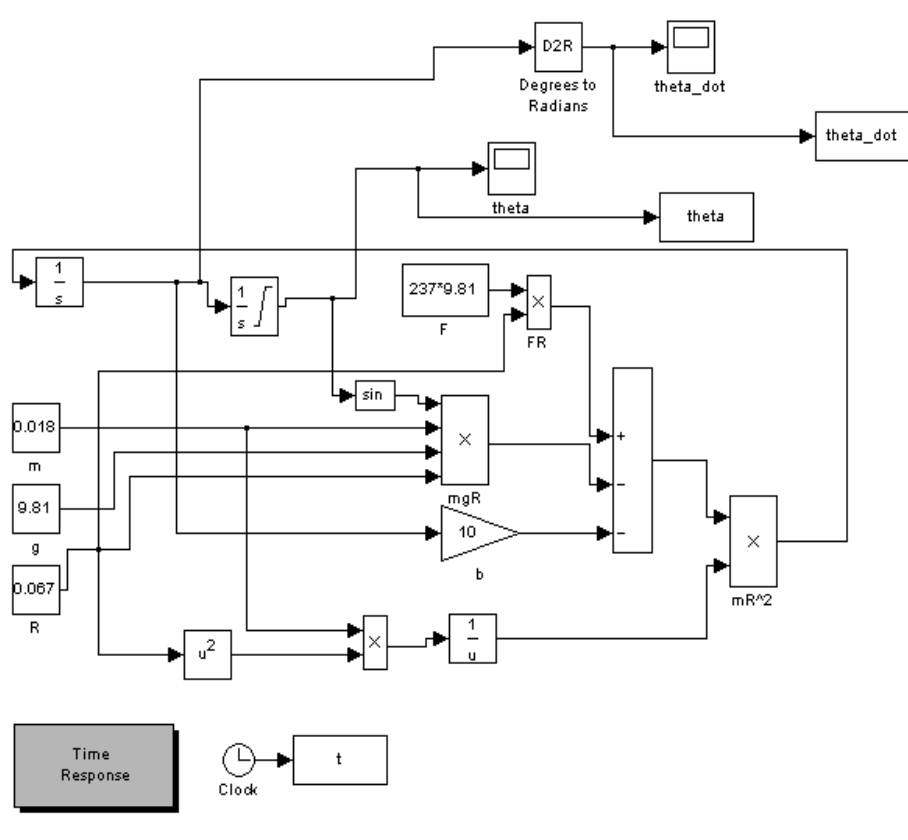
Fig. 4. Tilt tester model using